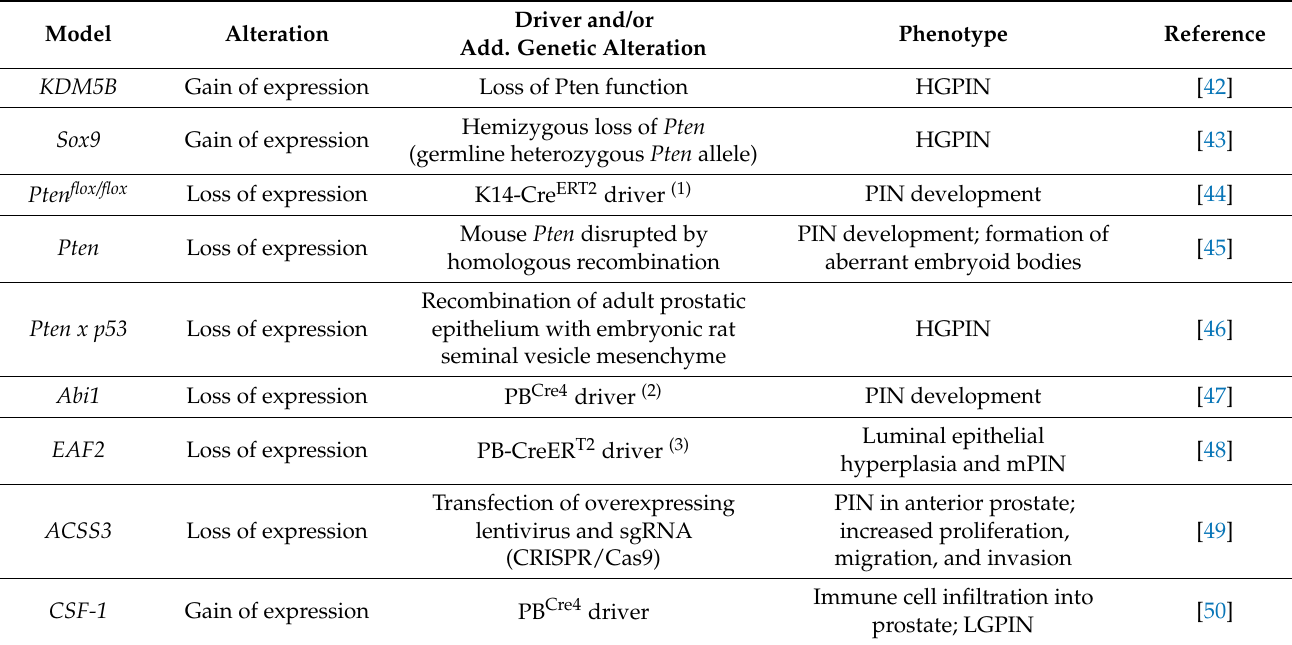
Table 3. PCa models in which PIN is documented.